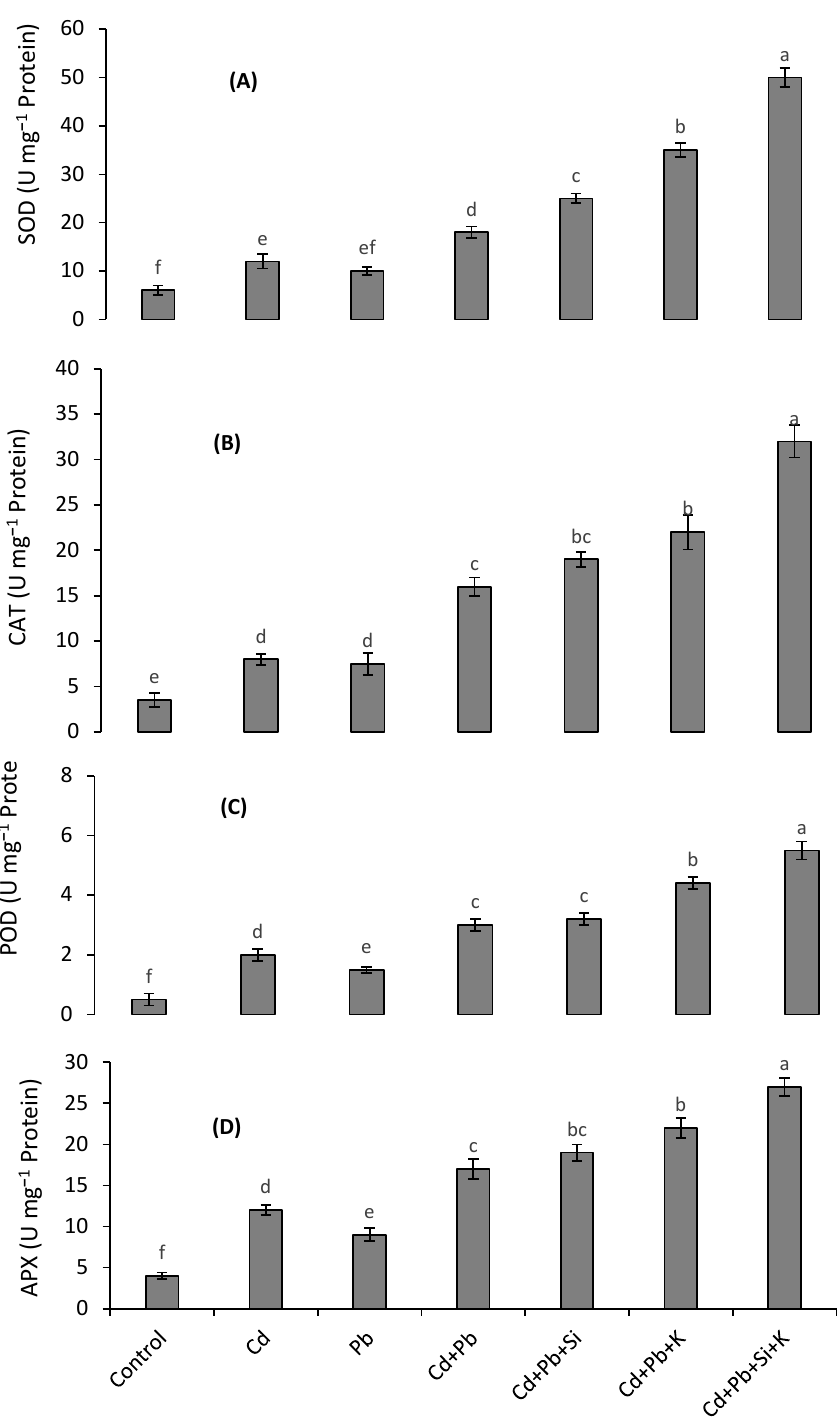
Figure 2. Effects of different Cd and Pb treatments on the activities of SOD ( A ), CAT ( B ) POD ( C ) and APX ( D ) on quinoa with and without supplementation with Si and K. Bars with different letters indicate the significant difference among the treatments at 5% significance level.